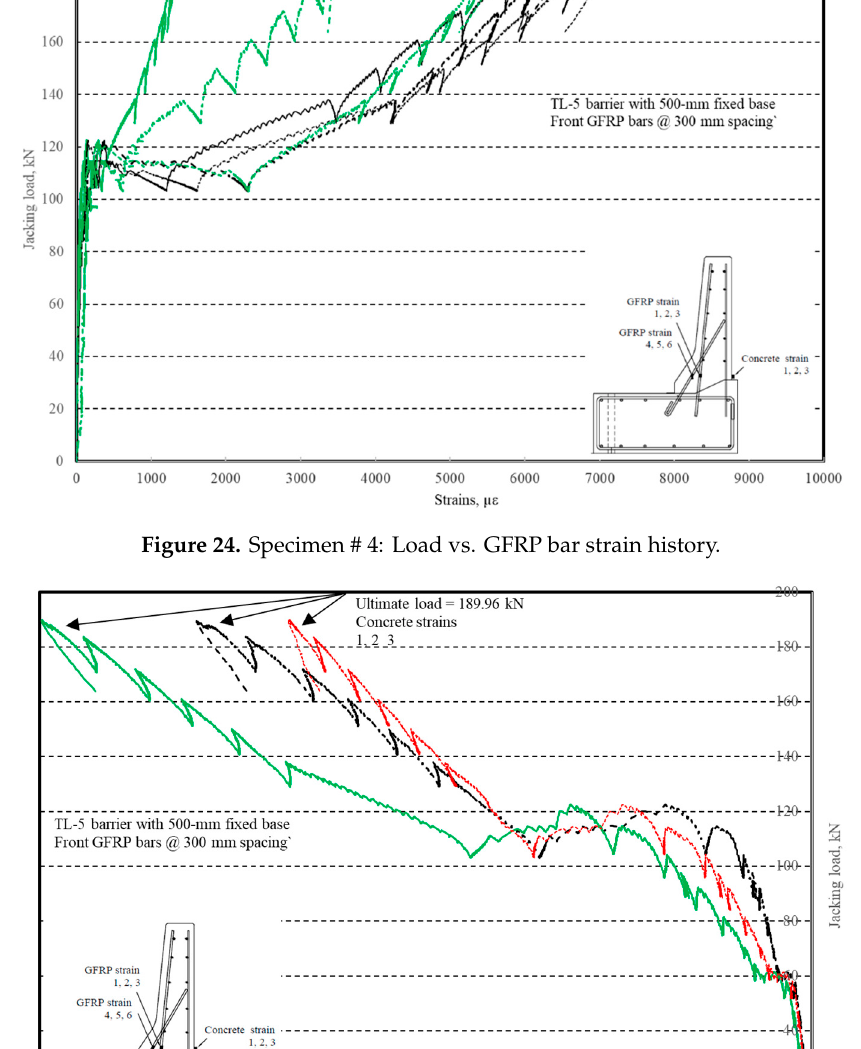
Figure 23. Specimen # 4: Load vs. displacement history.